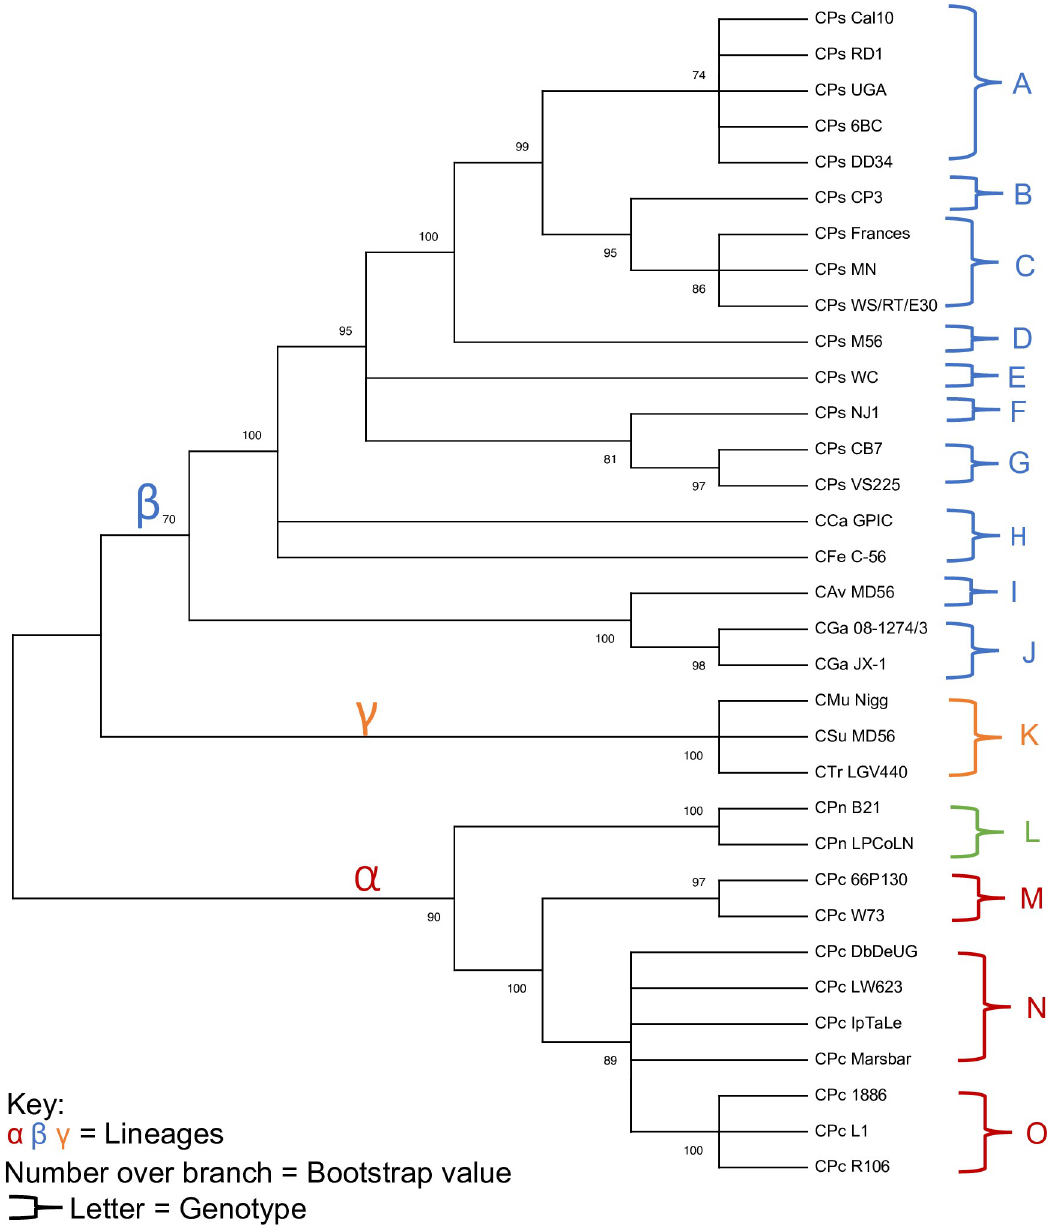
Fig 3. The Maximum Likelihood estimate for 33 ompA strains with a log likelihood of